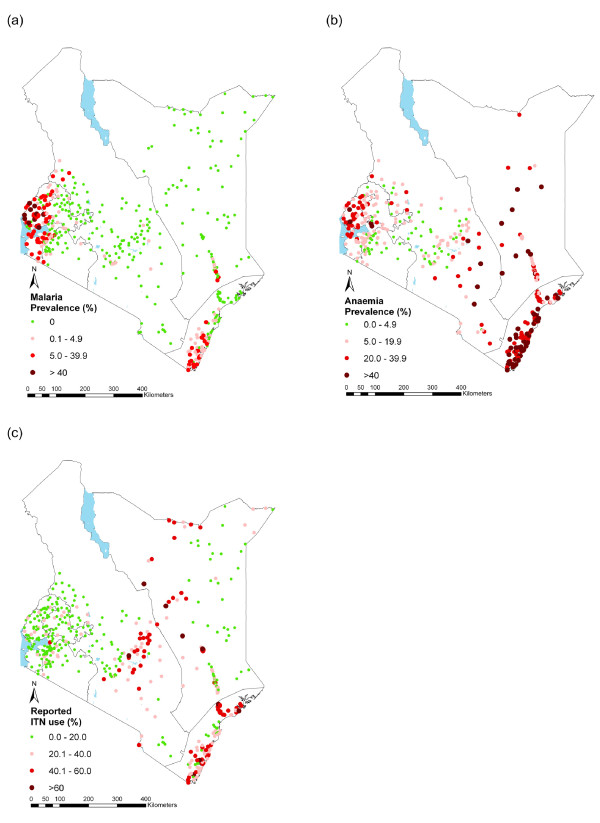
The geographical distribution of (a) Malaria infection in 480 schools, (b) anaemia adjusted for age, sex and altitude in 399 schools, and (c) reported insecticide net use among school children in 480 schools across Kenya, September 2008-March 2010. Note: Haemoglobin was not assessed in some schools in the North Eastern Kenya. Classification based on the WHO categories of anaemia for public health importance (WHO, 2001).